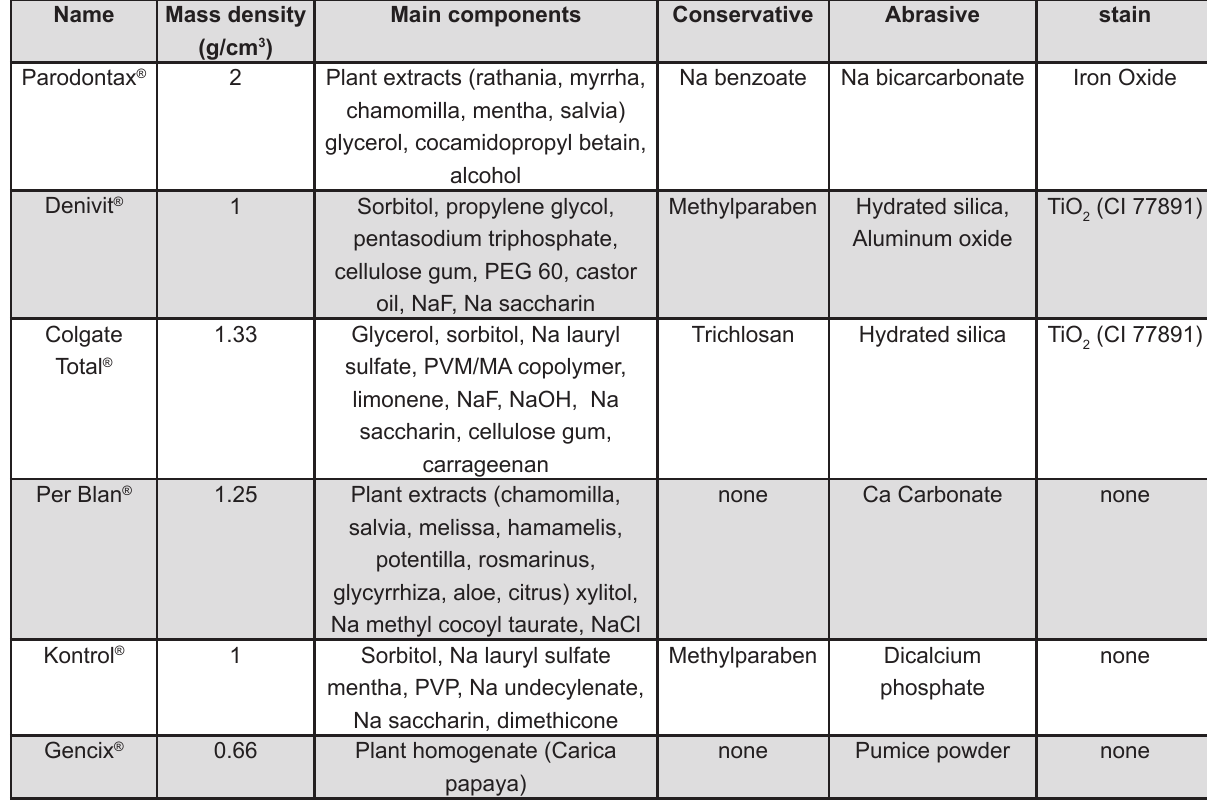
Figure 1- Composition of the 6 dentifrices (3 toothpastes, 3 toothpowders)